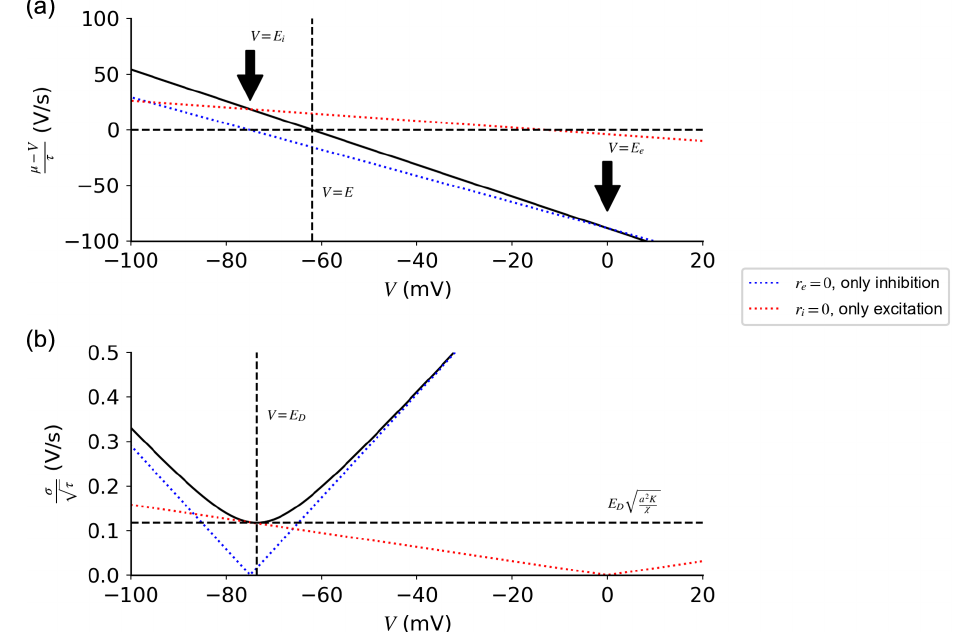
FIG. 8. Drift and diffusion terms of Eq. (4) as a function of the voltage. (a) Input drift as a function of membrane potential V produced with both inhibitory and excitatory inputs (black line), excitatory inputs only (red dotted line), or inhibitory inputs only (blue dotted line). The drift term decreases monotonically with V , and it is zero at V ¼ μ , which is a stable fixed point of the deterministic dynamics. (b) The noise variance is quadratic in V . Its minimum at V ¼ E S is equal to E D variance are obtained at different values of V